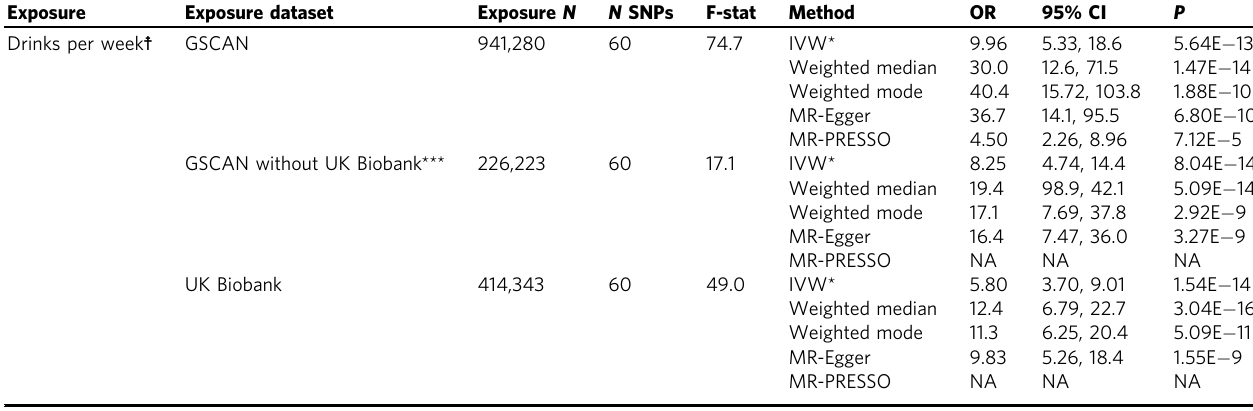
Table 2 Univariable Mendelian randomisation of alcohol consumption and risk of oral and oropharyngeal cancer.